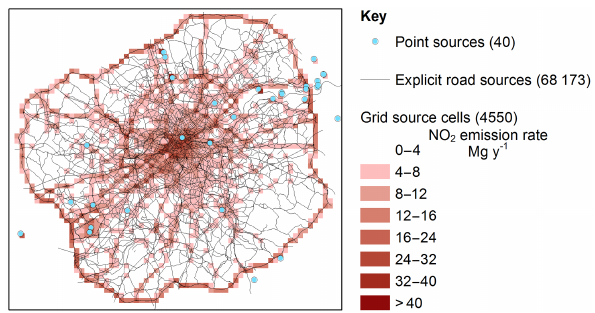
Figure 4. London 2012 emissions inventory, with source counts given in brackets in the key. Note that railway and river shipping sources are represented by road sources with altered source proper- ties. The gridded sources are 1km × 1km in